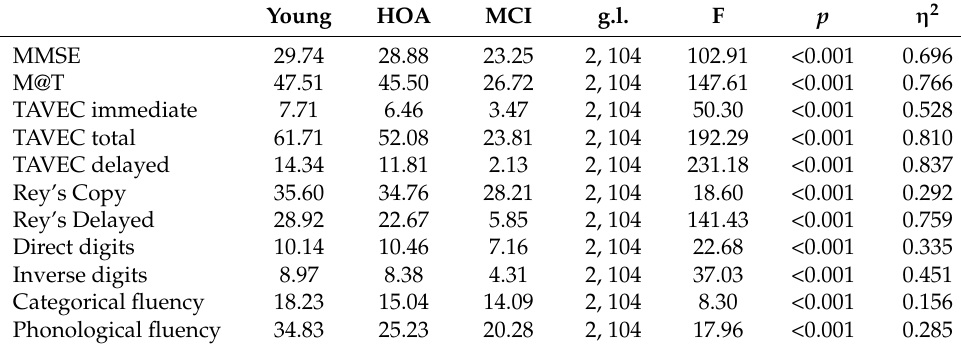
Table 1. Descriptive statistics and results of the ANOVAs of the cognitive